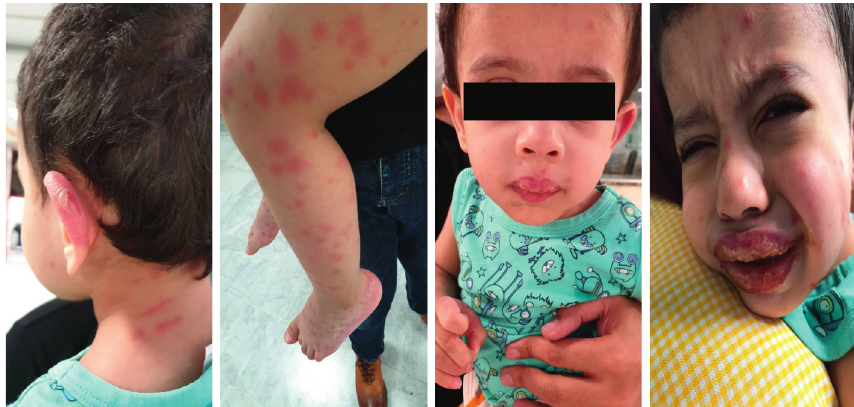
Figure 1: Skin lesions in the patient upon arrival at the hospital.